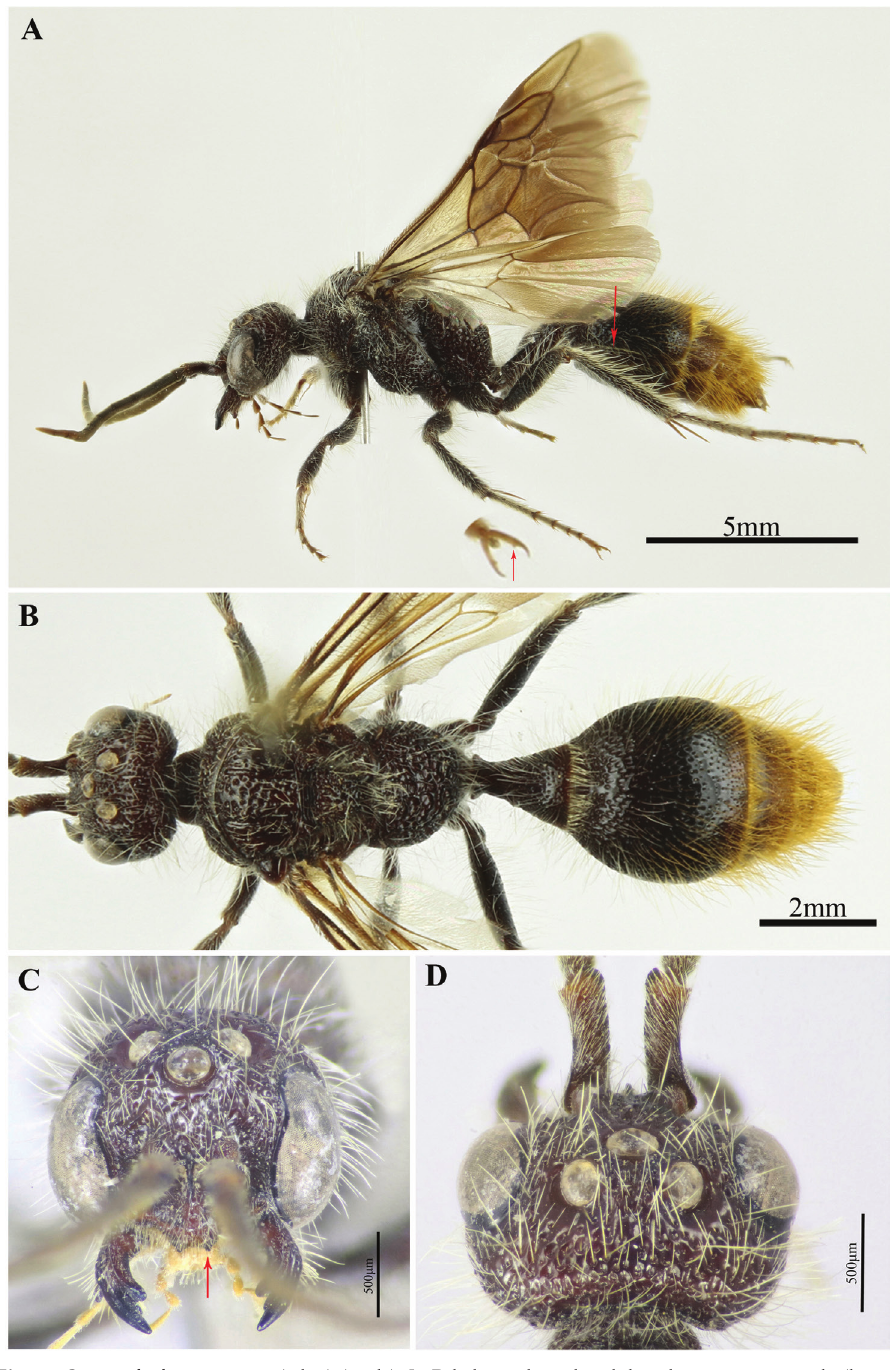
Figure 3. Pseudophotopsis aurea (Klug) (Male) A, B habitus, lateral and dorsal views, respectively (lateral felt line on T2 indicated, ventral denticle on tarsal claw in magnified pretarsus indicated) C head, frontal view (denticulations on clypeal free margin indicated) D head and antennal scape, dorsal